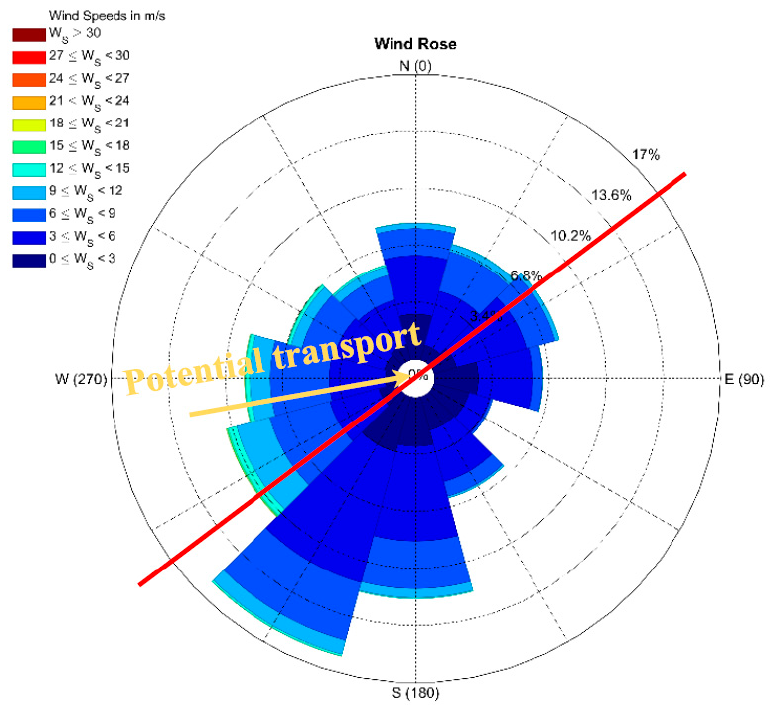
Figure 22. Measured wind speed (W s ) and wind direction at Ostend Airport weather station for the period 2000–2017. The red line represents the Belgian coastline direction. The potential transport drift is also given.